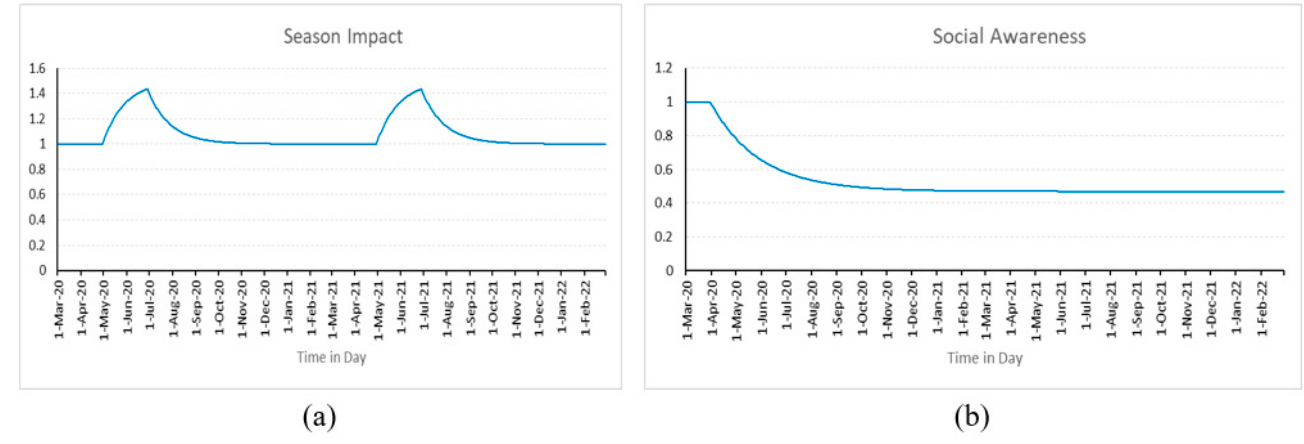
Figure 2. Behavior of ( a ) Contact rate; ( b ) Lockdown plan.